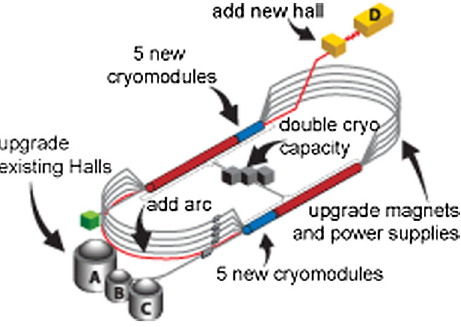
FIG. 1. Continuous Electron Beam Accelerator